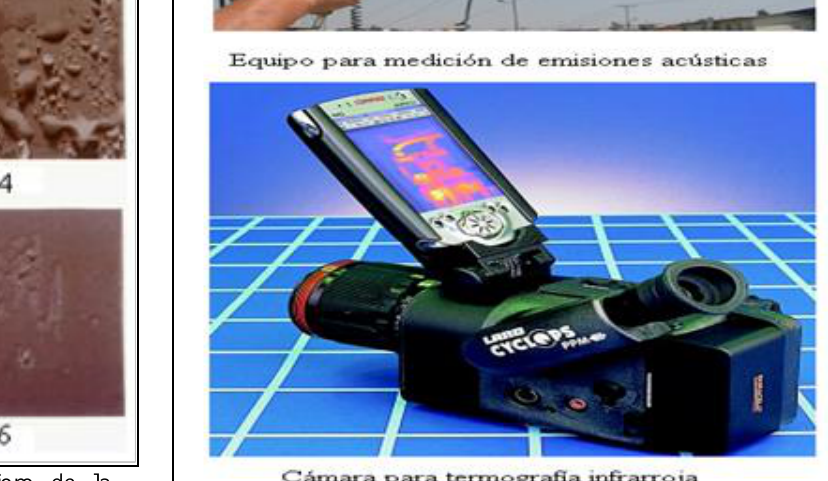
Figura 2. Método STRI para determinar deterioro de la propiedad de hidrofobicidad en el aislamiento sintético. Fuente: Autor, (2018).